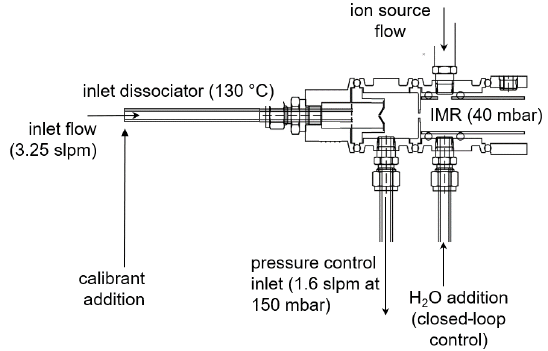
Figure 1. Instrument inlet